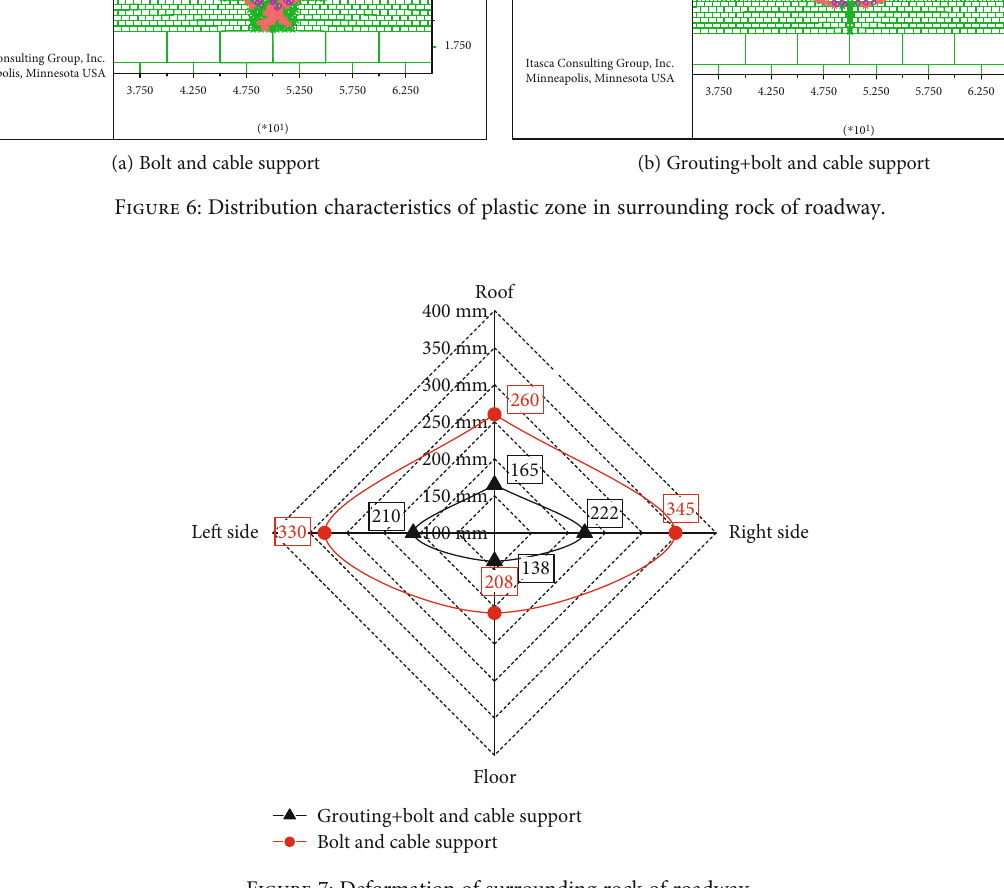
Figure 7: Deformation of surrounding rock of